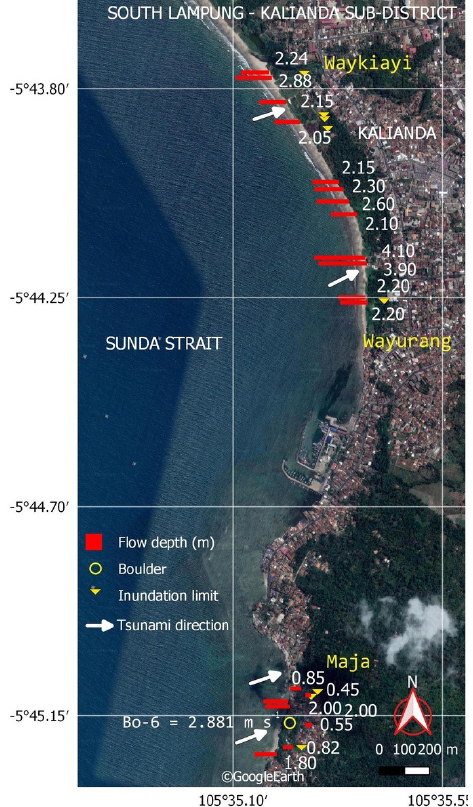
Figure 9. Flow depth distribution and run-up limits in Kalianda, South Lampung. Green bars and yellow triangles represent flow heights and inundation limits measured at the locations, respec- tively. (The base map was adapted from Google Earth.)